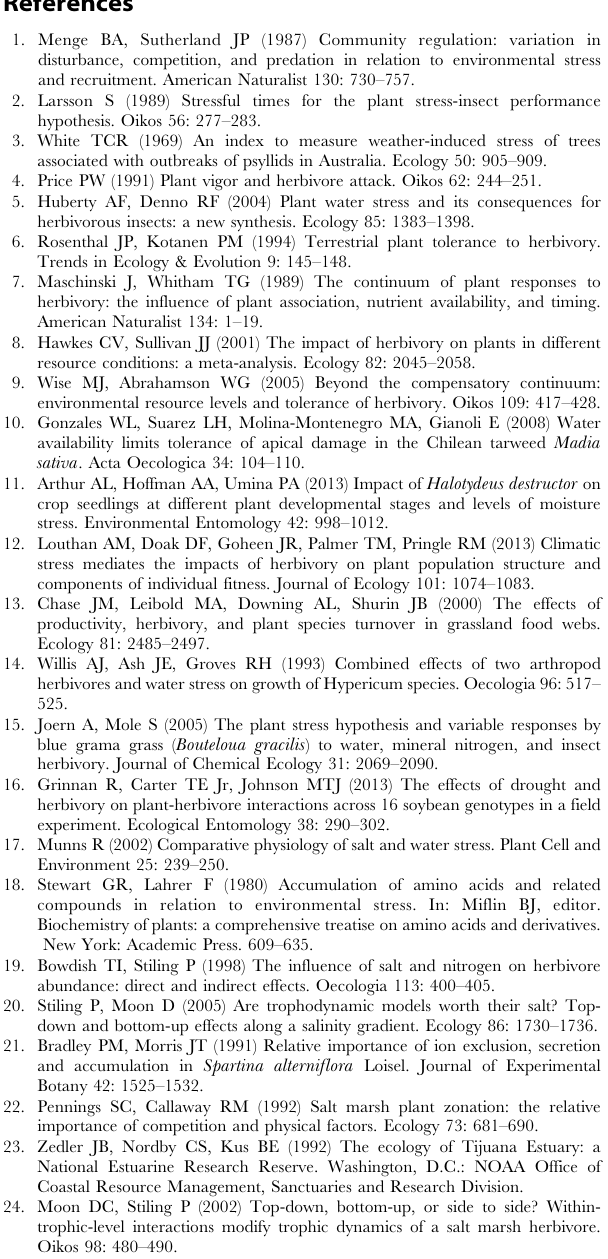
Figure S4 Densities of scales on stems during the 2012 field experiment. To highlight site and salt effects, data are shown separately for Scale (A) and No Scale (B) stems. Values are means 6 SE. Table S1 ANOVA table examining the effects of factors on Spartina growth during the 2011 Mesocosm experi- ment. Table S2 ANOVA table examining the effects of factors on days to Spartina senescence during the 2012 Field